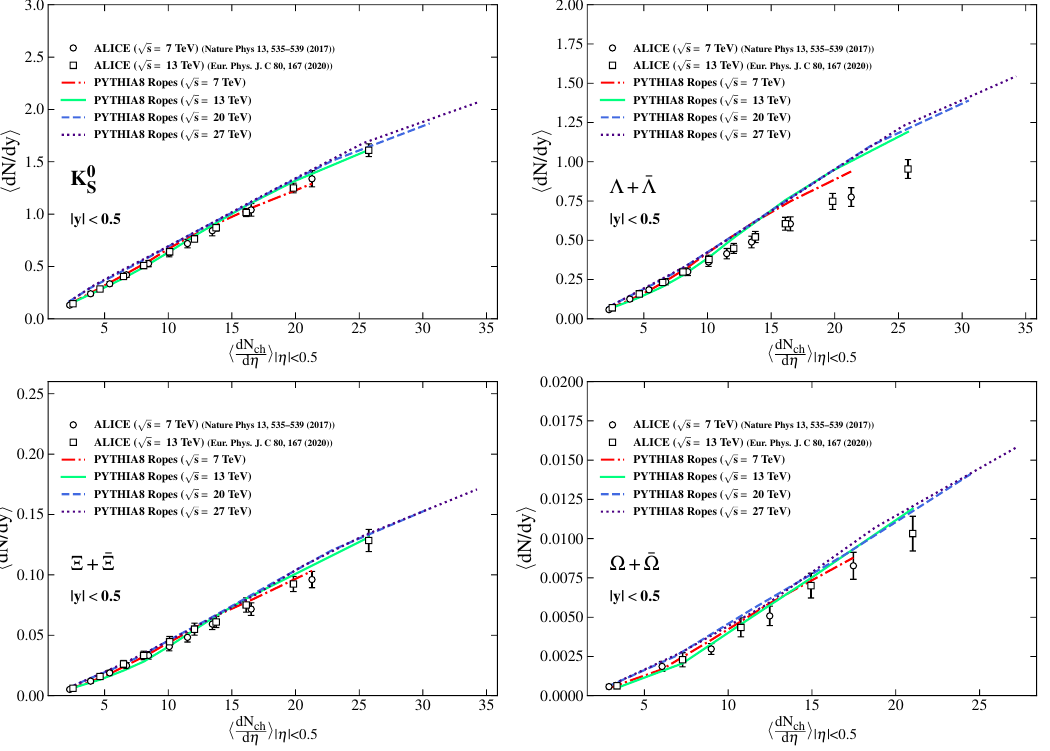
< 0.5 at dN ch / d η y measured in (cid:104) (cid:105) | |